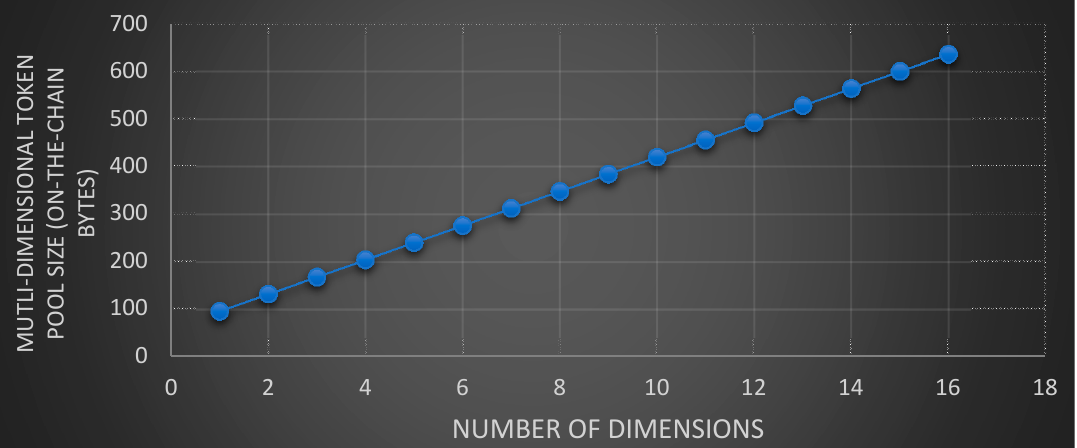
Figure 20. Dependency of the resulting Token Pool’s data structure size on the numerosity of di-